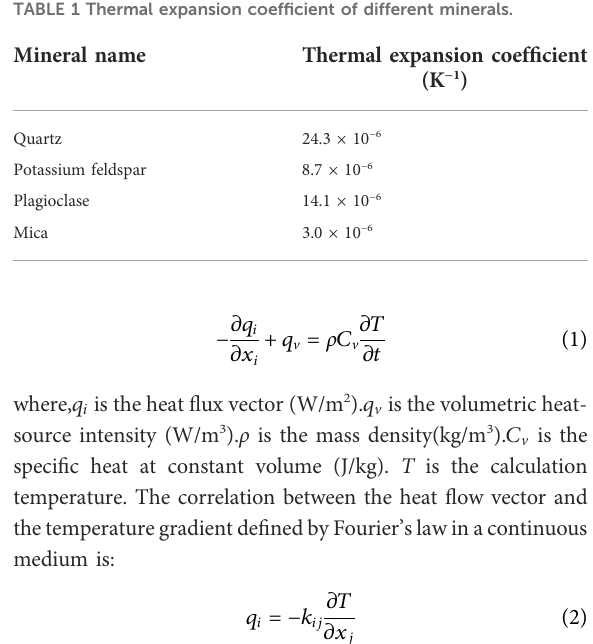
TABLE 1 Thermal expansion coef fi cient of different